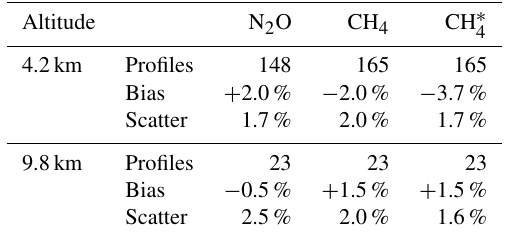
Table 4. Statistics on the difference with respect to HIPPO data (MUSICA IASI − HIPPO). The bias is the median and the scatter is the IP68 value (i.e. the semi-distance between the percentiles 84.1 and 15.9). The statistical estimators are shown for comparisons at 4.2 and